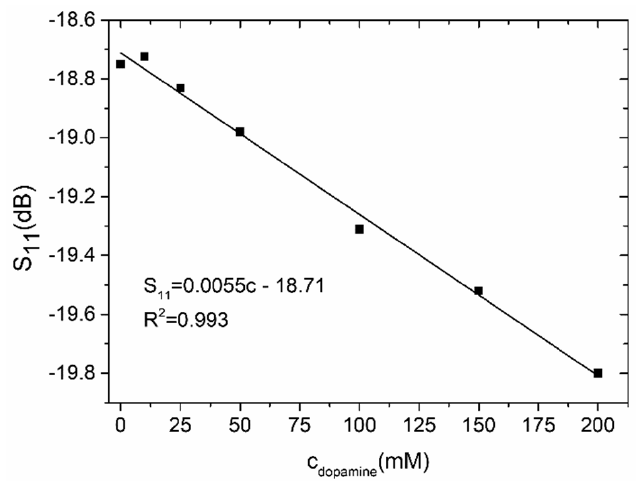
Figure 14. Reflection coefficient as a function of the dopamine concentration.